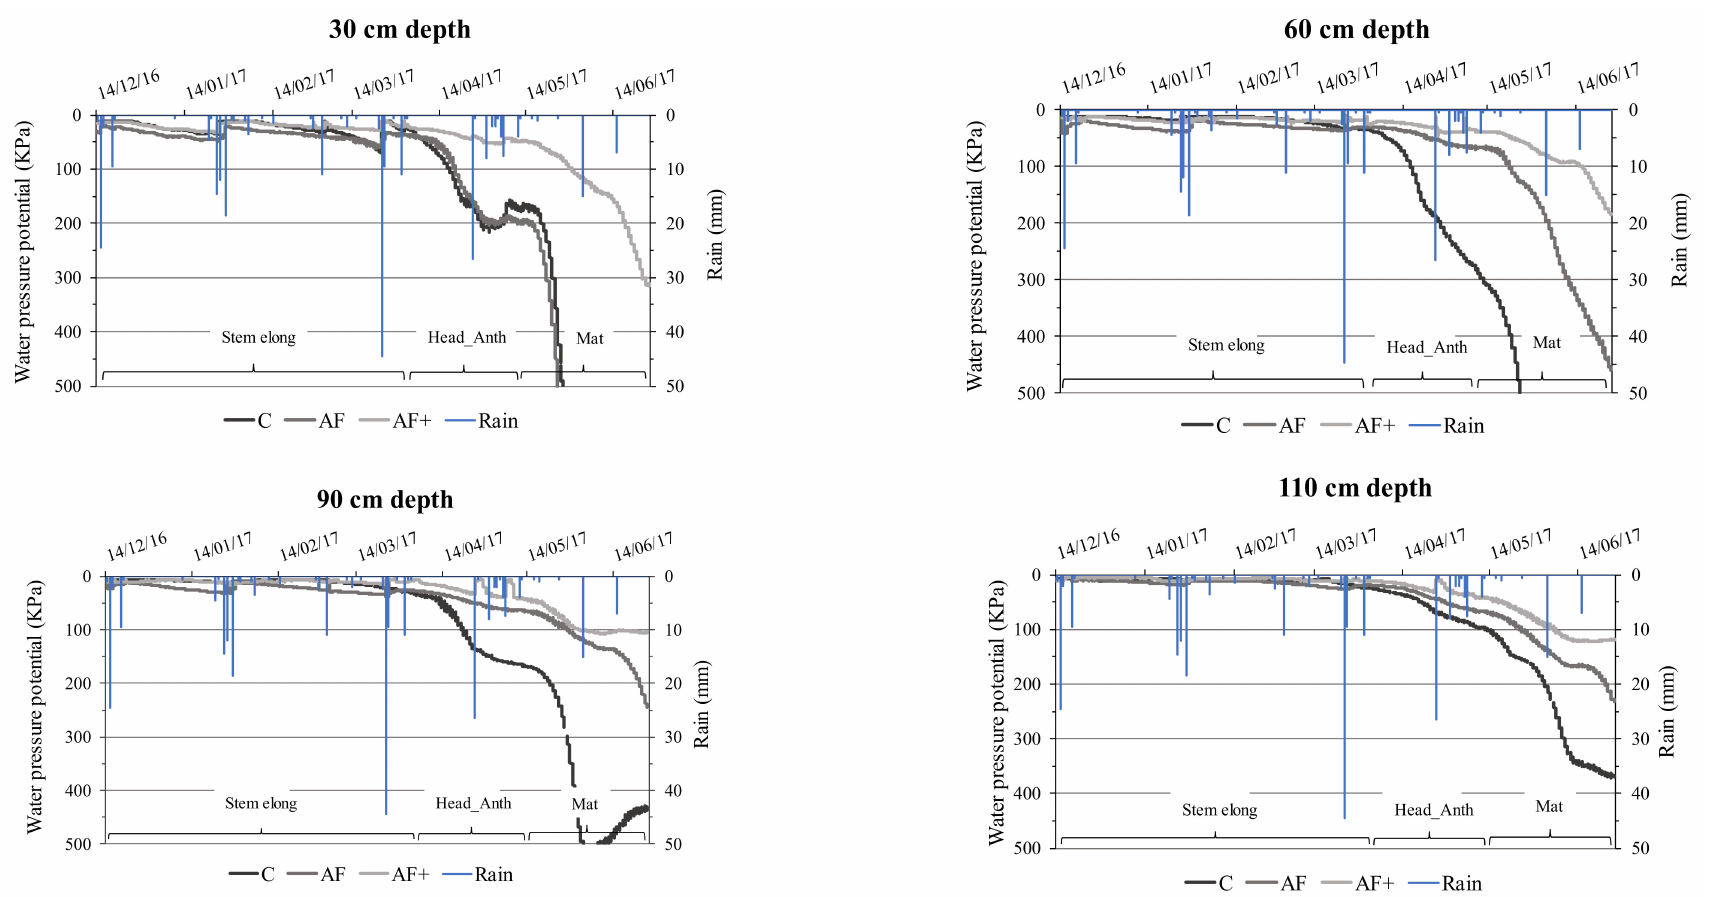
Figure 3. Soil water potential as hourly average pressure potential (KPa) recorded by tensiometers placed in the three treatments (C, AF and AF+) at four soil depths, i.e., 30 ( top-left ), 60 ( top-right ), 90 ( bottom-left ) and 110 ( bottom-right ) cm, during the 2nd year (2016–17) wheat growing season. Timeline in the x axis is divided into three wheat cycle periods: stem elongation (Stem elong) (from sowing to 7 April), heading and anthesis (Head_Anth) (from 8 April to 10 May) and maturity (Mat) (from 11 May to harvesting). The secondary vertical axis indicates daily rainfall (mm) within the same